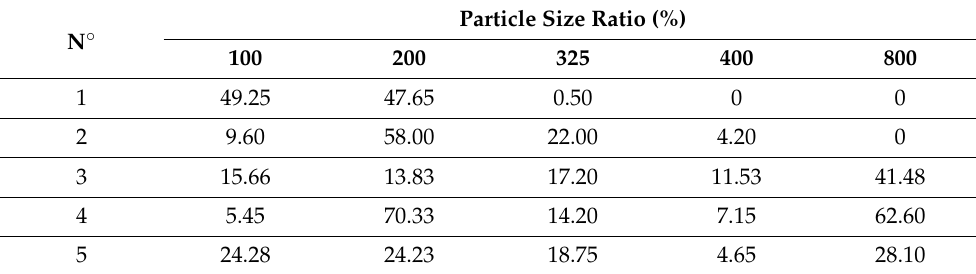
Table 1. Tailings particle size classification experiment.